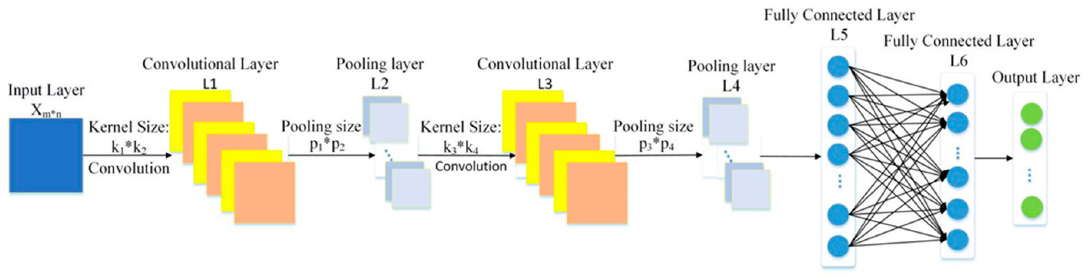
Figure 2. A typical architecture of CNN.